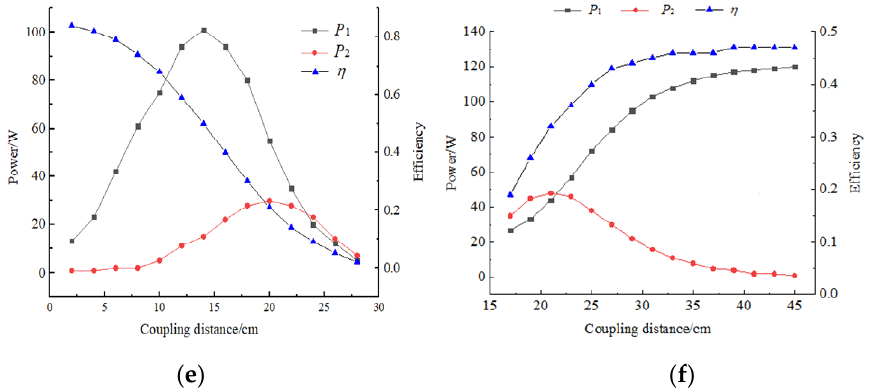
Figure 13. Curve of coupling distance and system parameters. ( a ) Coaxial opposite side. ( b ) Different axis same side. ( c ) Different axis coplanar. ( d ) Synchronous changes in l 1 and l 2 on the same coaxial side. ( e ) Synchronous changes in l 1 and l 2 on the same coaxial side. ( f ) Only l 1 changes on the same side of the coaxial.